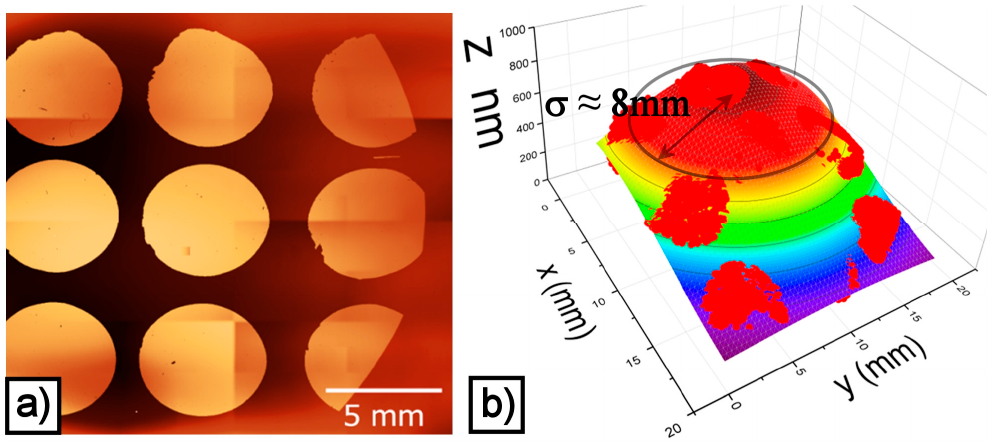
Figure A1. ( a ) 25 × 25 mm 2 multi-tile optical profilometry image of a 700 nm thick Ag NP Film; ( b ) Optical profilometry data are fit with a bi-dimensional Gaussian profile with a parameter σ = 8 mm. The ellipsometer source light beam incident at 65° from sample normal projects a spot on the central region of the sample not larger than 4–5 mm: the maximum thickness gradient expected in the probed region of the sample is expected to be less than 5% of the maximum sample thickness. For an 80 nm thick layer expected thickness variation is less than 4 nm, very likely inside the expected surface roughness.